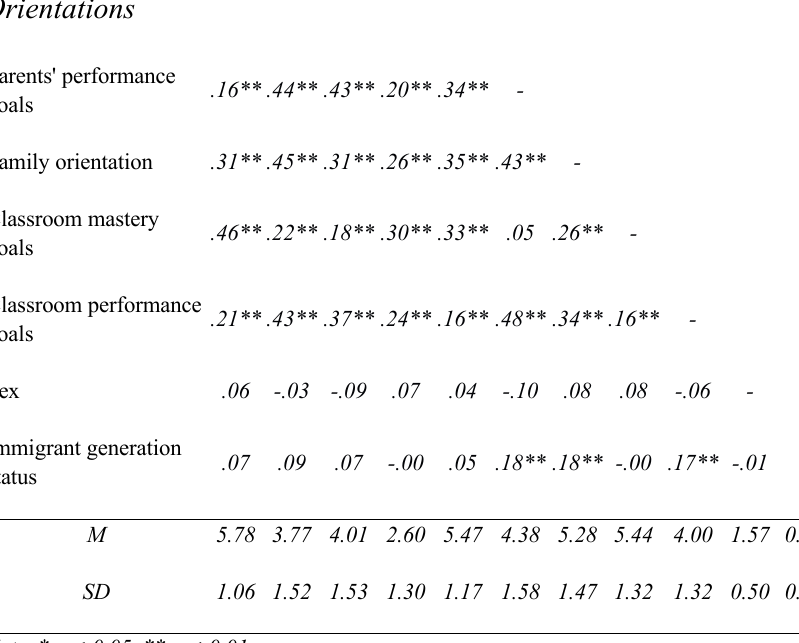
Standardized Direct and Indirect Effects (for Paths with Significant Effects